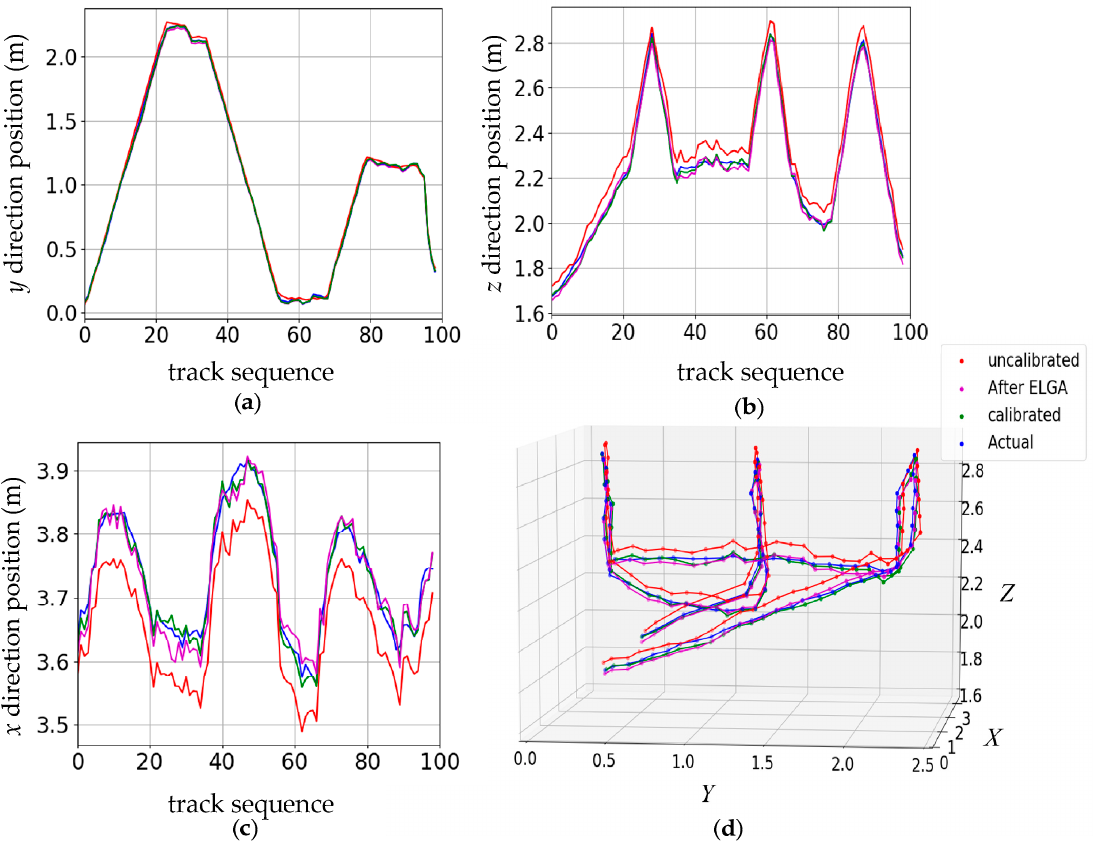
Figure 10. The “III” shape trajectory:( a ) the motion curve in the y direction; ( b ) the motion curve in the z direction; ( c ) the motion curve in the x direction; ( d ) three-dimensional graph of the trajectory. In ( a )–( c ) The horizontal axis represents the track sequence number obtained according to the routing order.